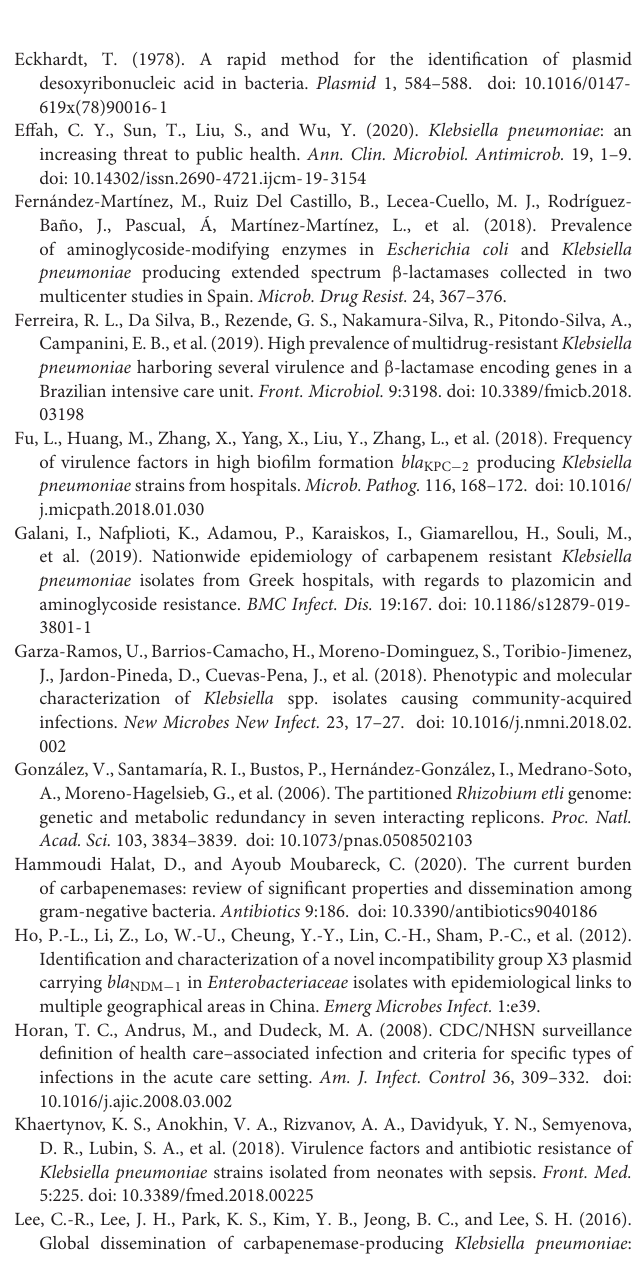
Supplementary Figure 1 | Genetic relationship and molecular characteristics of the 43 strains of K. pneumoniae carrying bla NDM − 1 and other resistance genes. Supplementary Figure 2 | Diagram of the different clonal complexes (CC) and the multilocus sequence types (STs) identified by eBURST in bla NDM − 1 -producing K. pneumoniae isolates. The ST (red circles) and the CC (green circles) obtained for each strain